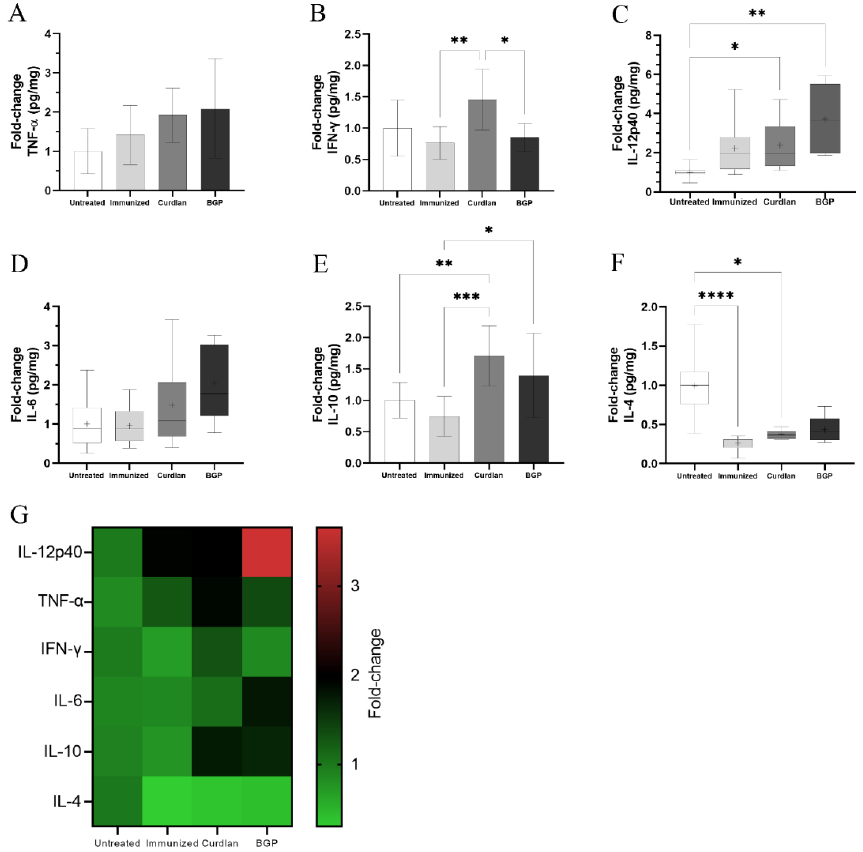
Figure 10. Measurement of cytokine levels in the lungs of immunized C57BL/6 mice challenged with C. gattii . After the administration of curdlan, β -glucan peptide (BGP), or PBS, C57BL/6 mice were immunized with HK- C. gattii -thin. On day 45 (14 d.p.i.), the mice were challenged with C. gattii . On day 59 (14 days post infection), mice lungs were harvested and homogenized, and the supernatants were used for measuring the levels of ( A ) TNF- α , ( B ) IFN- γ , ( C ) IL-12p40, ( D ) IL-6, ( E ) IL-10, and ( F ) IL-4 cytokines via ELISA. ( G ) Fold change (1–3 times) in the cytokine levels in all groups (in comparison to the untreated group) are represented in the heat map. Results are expressed as mean ± SD or as medians with interquartile ranges. * p < 0.05, ** p < 0.01, *** p < 0.001, and **** p <